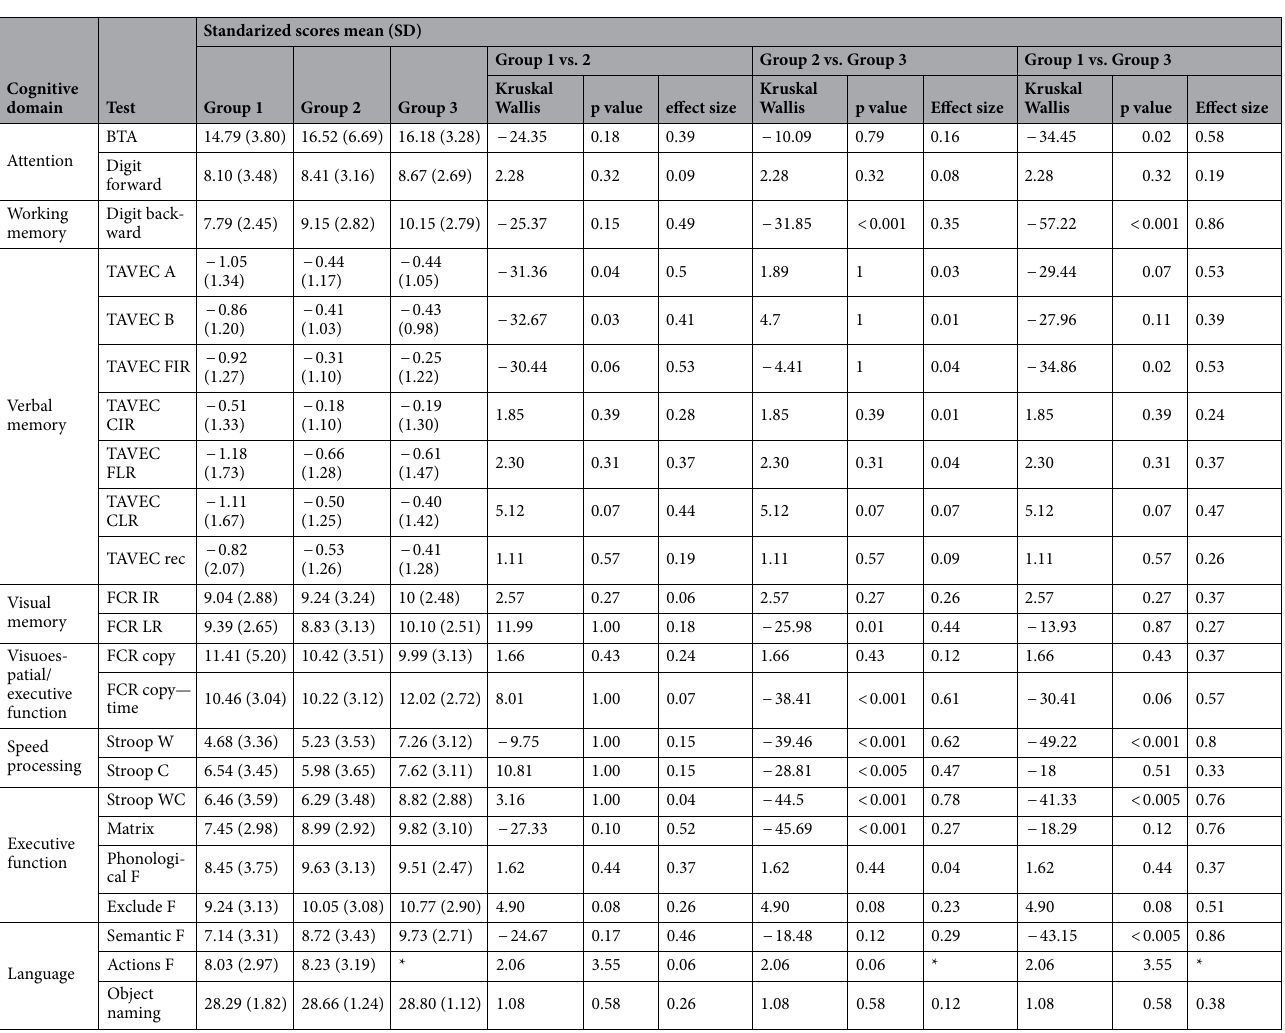
Table 3. Results in all neuropsychological test by